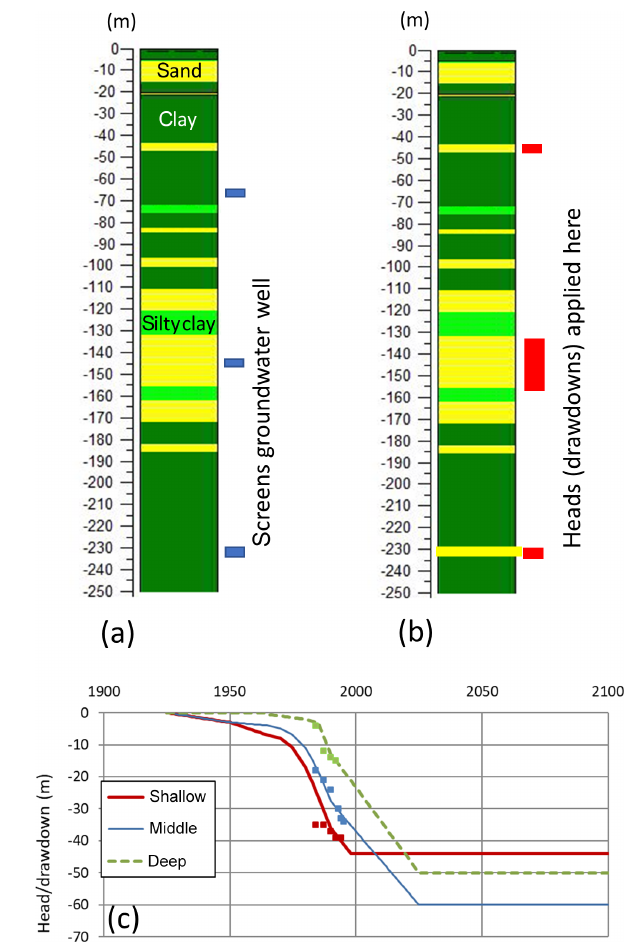
Figure 3. Borehole and well-data. (a) Geological borehole de- scription and depth of screens of the “nearby” observation well. (b) Modified borehole layering used in the modelling and depths where drawdowns are applied. (c) Observed drawdown (squares) and model time series of drawdown (lines) for the three drawdown levels. Table 2. Parameters for clay and sandy clay per run.